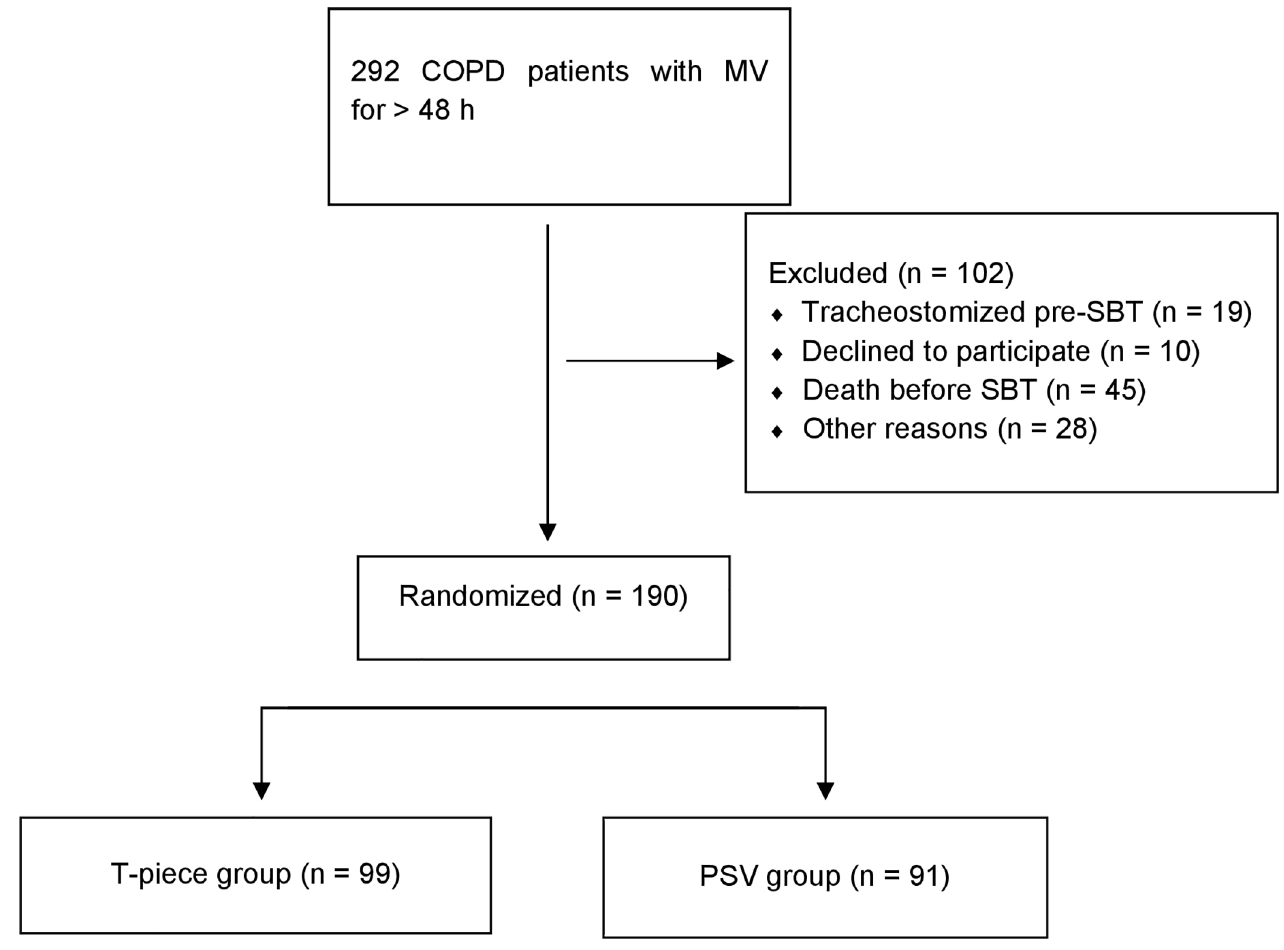
Fig 1. Patients enrollment and